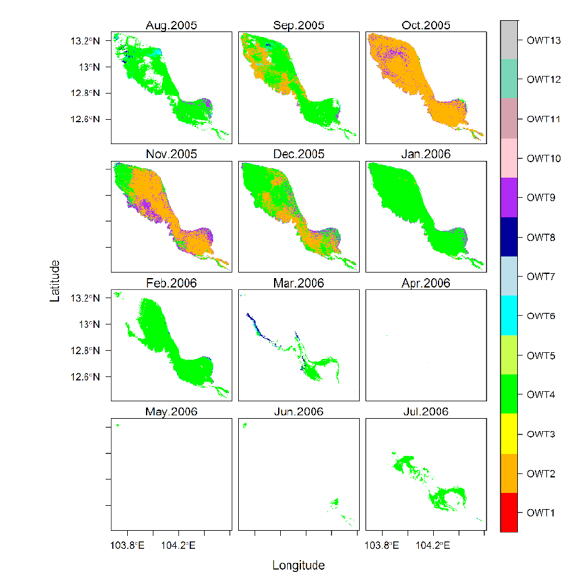
Figure 2. Dominant OWT over a yearly cycle in an ephemeral and highly dynamic freshwater body (Tonlé Sap) at the Cambodian